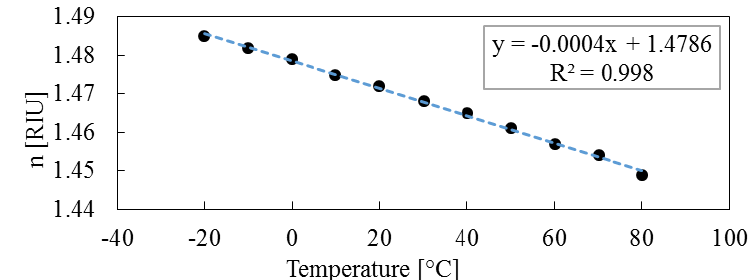
Figure 11. The computed RIs of RIMM in the temperature range from −20 and 80 °C.